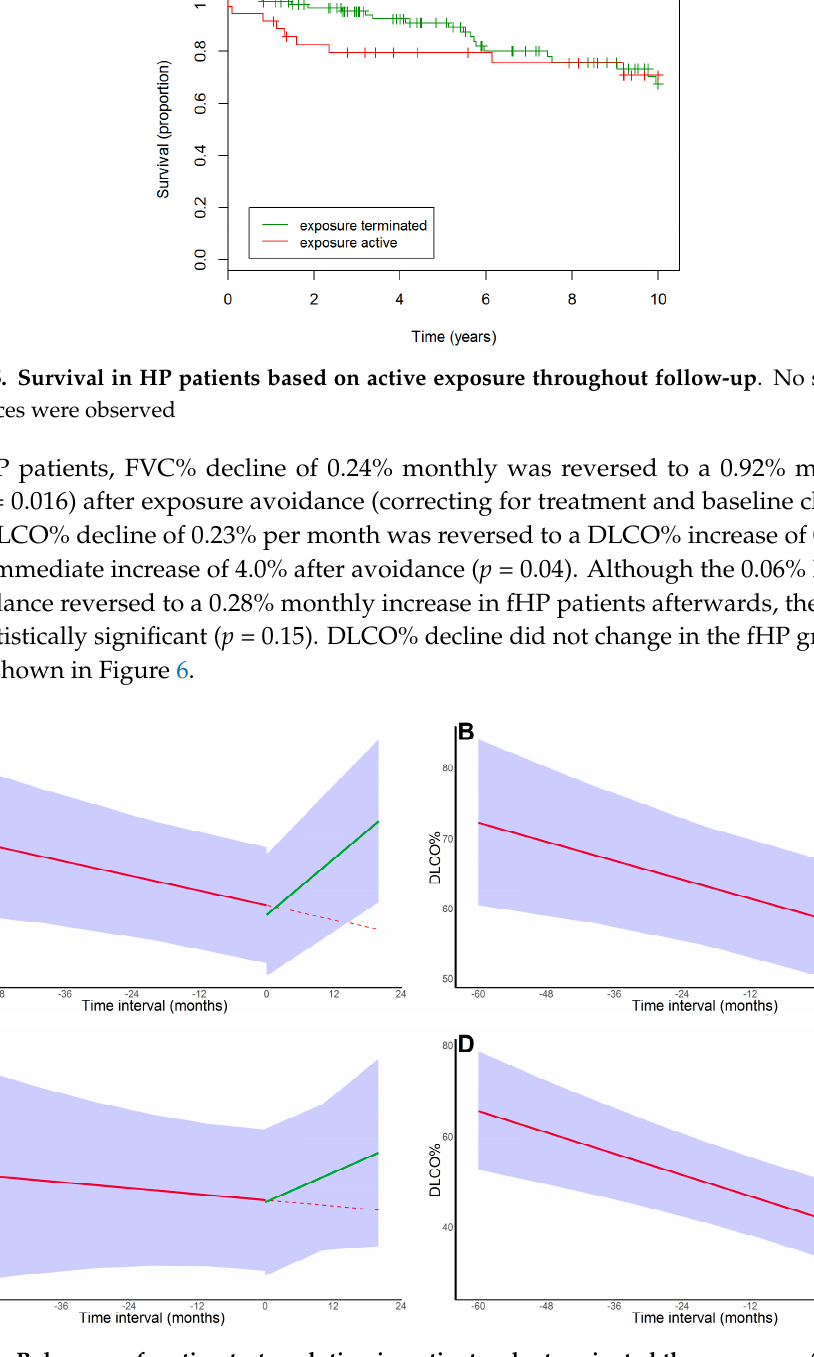
Figure 6. Pulmonary function test evolution in patients who terminated the exposure. ( A ). FVC% trajectory in nfHP patients; ( B ). DLCO% trajectory in nfHP patients; ( C ). FVC% trajectory in fHP patients; ( D ). DLCO% trajectory in fHP patients. nfHP patients experienced both an FVC% and DLCO% increase after exposure avoidance. fHP patients experienced a non-significant trend towards FVC% increase after exposure avoidance ( p = 0.15). The solid red line represents the mixed effect model estimates before exposure termination, the solid green line represents the mixed effect model estimates after exposure termination and the dotted red line represents the pre-treatment trend.